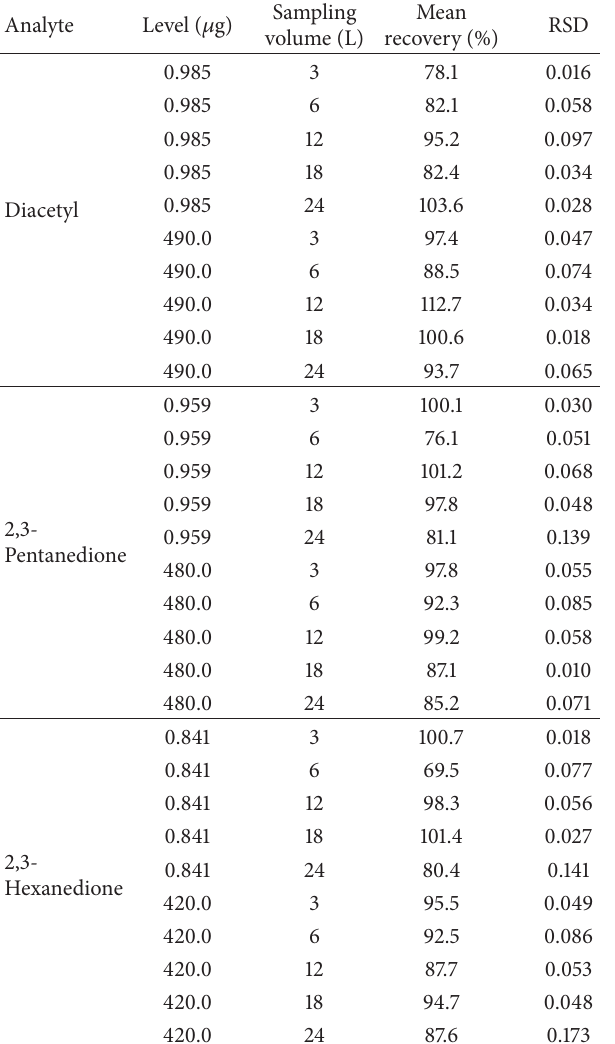
Table 9: Determination of air sampling capacity of o -PDA-treated silica gel tubes at 80% relative humidity at 2 concentration levels.